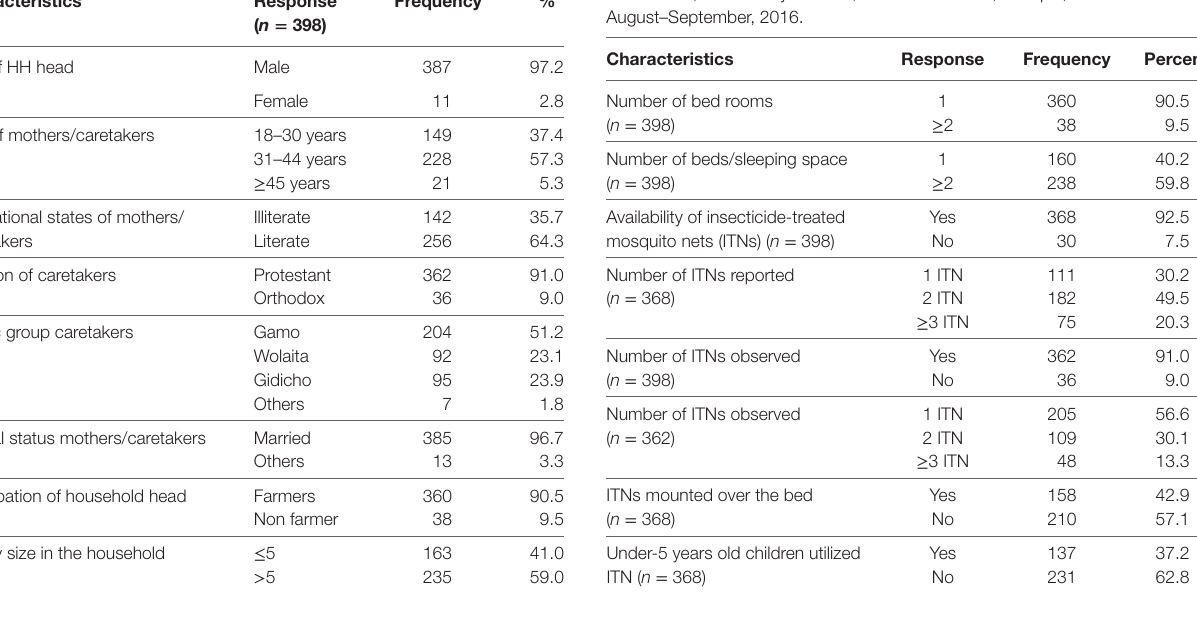
TaBle 1 | Sociodemographic characteristics of households, Mirab Abaya District, Gamo Gofa Zone, Ethiopia, August–September, 2016. characteristics